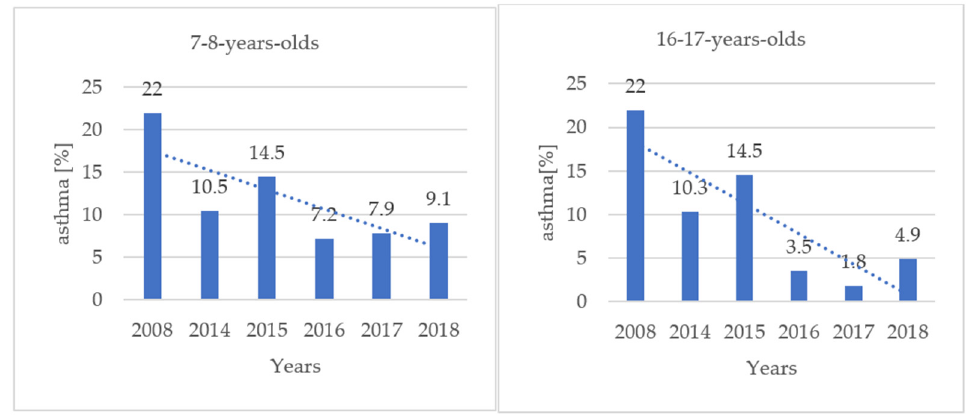
Figure 3. Incidence of asthma in examined groups (seven to eight years, 2066 patients regression coefficient = − 0.908 p = 0.012 and 16–17 years, 763 patients, regression coefficient = − 0.898; p = 0.015) in 2008–2018 (2009–2013 non tested).